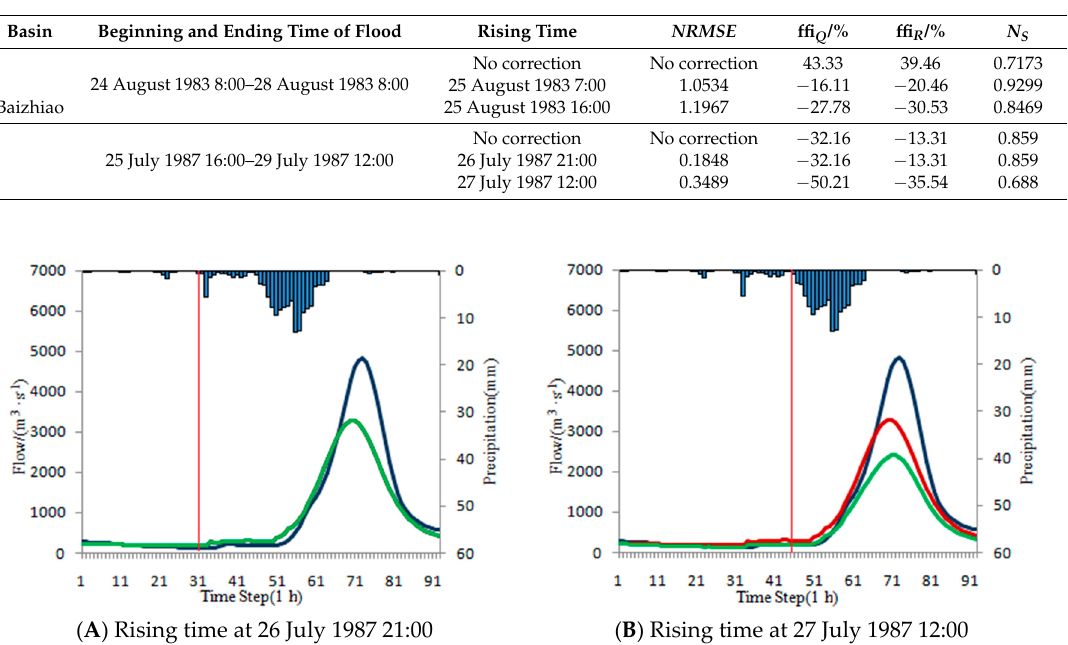
Figure 15. The flood from 25 July 1987 16:00 to 29 July 1987 12:00 in Baizhiao basin. Table 23. Different results of flood correction under different steady periods.